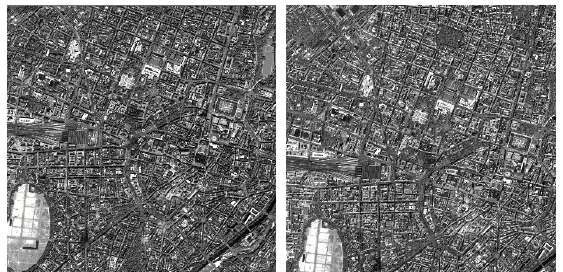
Figure 2. WorldView-2 stereo image of Munich